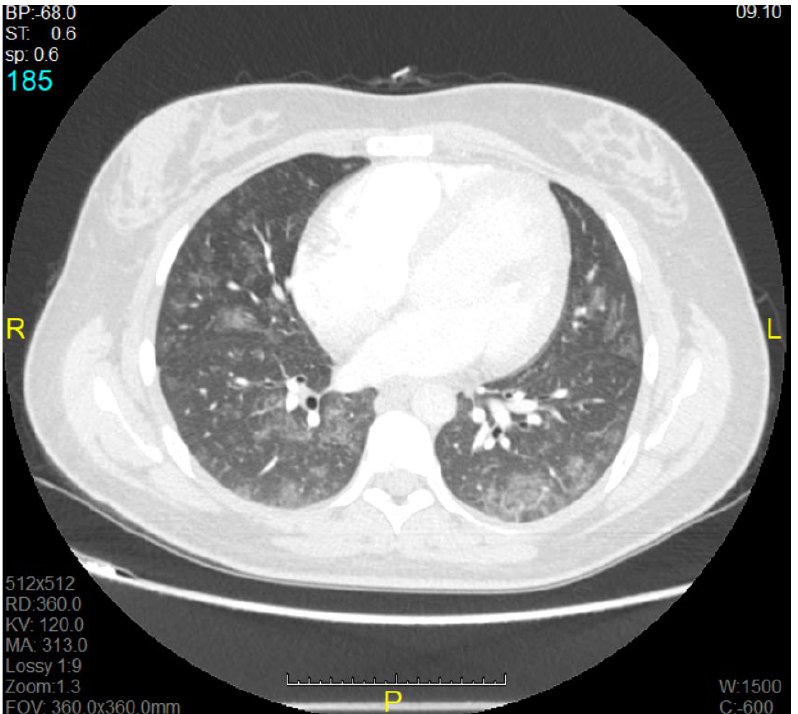
Figure 1. Computerised tomography (CT) image of a pregnant woman with acute respiratory distress syndrome (ARDS).